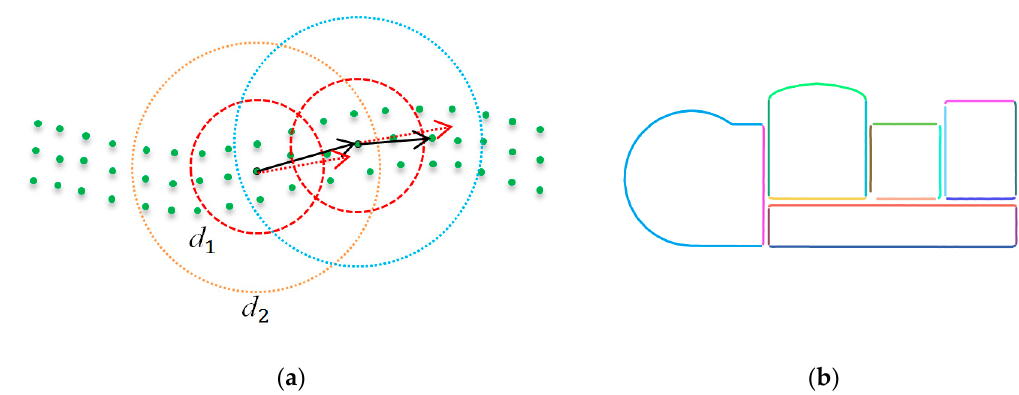
Figure 5. ( a ) Illustration of straight and curved line tracing; ( b ) wall line detection results.